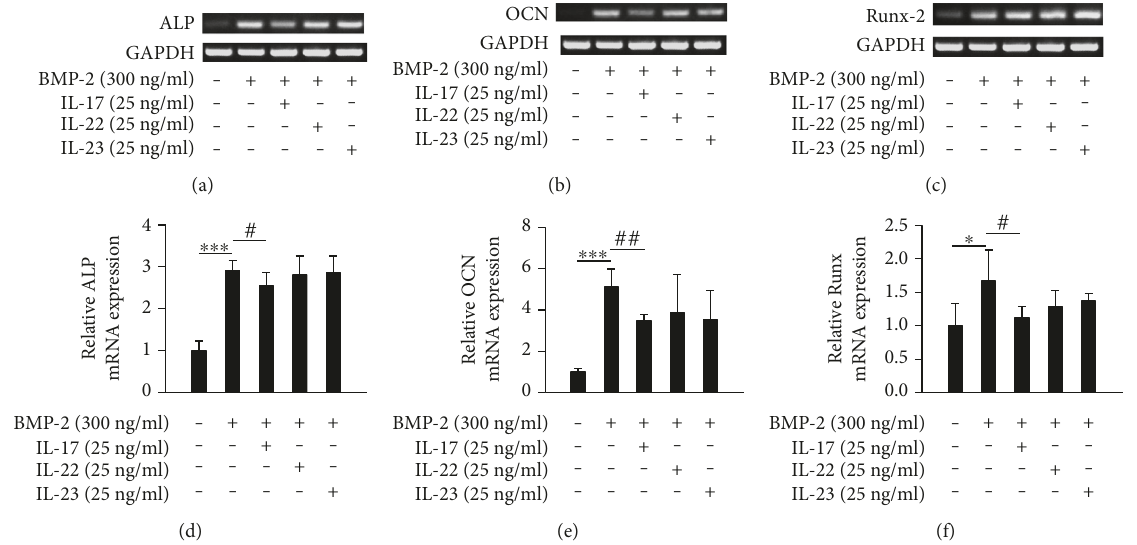
Figure 4: The e ff ects of IL-17, IL-22, and IL-23 on mRNA expression of markers associated with osteogenic di ff erentiation in primary calvarial osteoblasts. (a, b, c) Phenotypic markers of osteogenic di ff erentiation (ALP, OCN, and Runx-2) were determined by RT-PCR in cells cultured with the di ff erentiation inducer BMP-2 (300ng/ml) in the presence or absence of IL-17 (25 mg/ml), IL-22 (25 mg/ml), or IL- 23 (25 mg/ml) for 24 h. GAPDH was used as an internal control. (d, e, f) Phenotypic markers of osteogenic di ff erentiation (ALP, OCN, and Runx-2) were analyzed by quantitative real-time RT-PCR. The copy number of ALP, OCN, and Runx-2 mRNA was standardized with the copy number of GAPDH mRNA. ∗ p < 0 05 , ∗∗∗ p < 0 001 compared with untreated control; # p < 0 05 , ## p < 0 01 compared with the cells stimulated with BMP-2 alone.